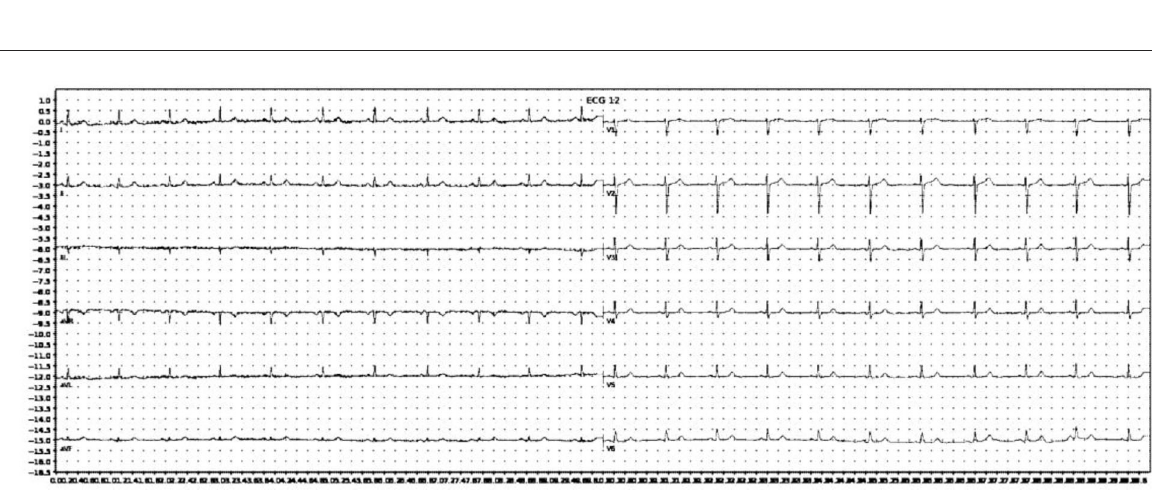
FIGURE2 Example of an ECG image after grayscale conversion and adaptive